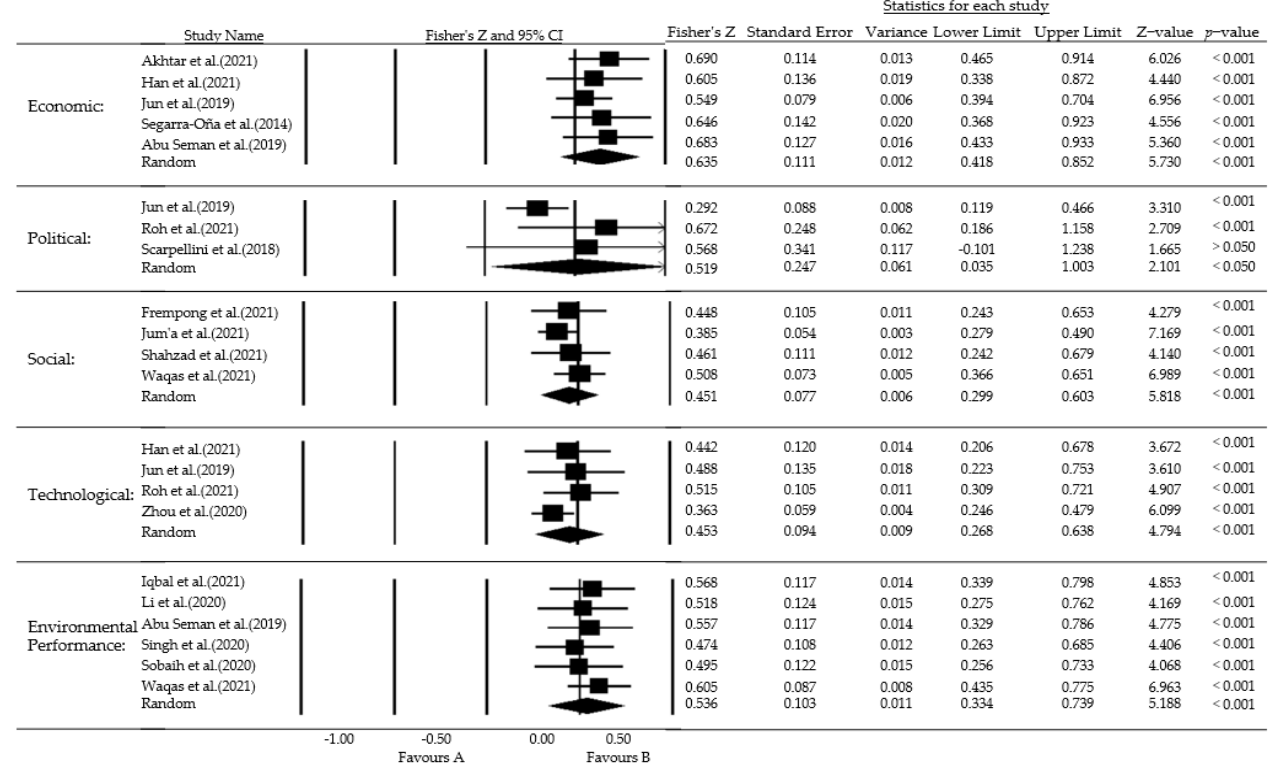
Table 5. The main effect